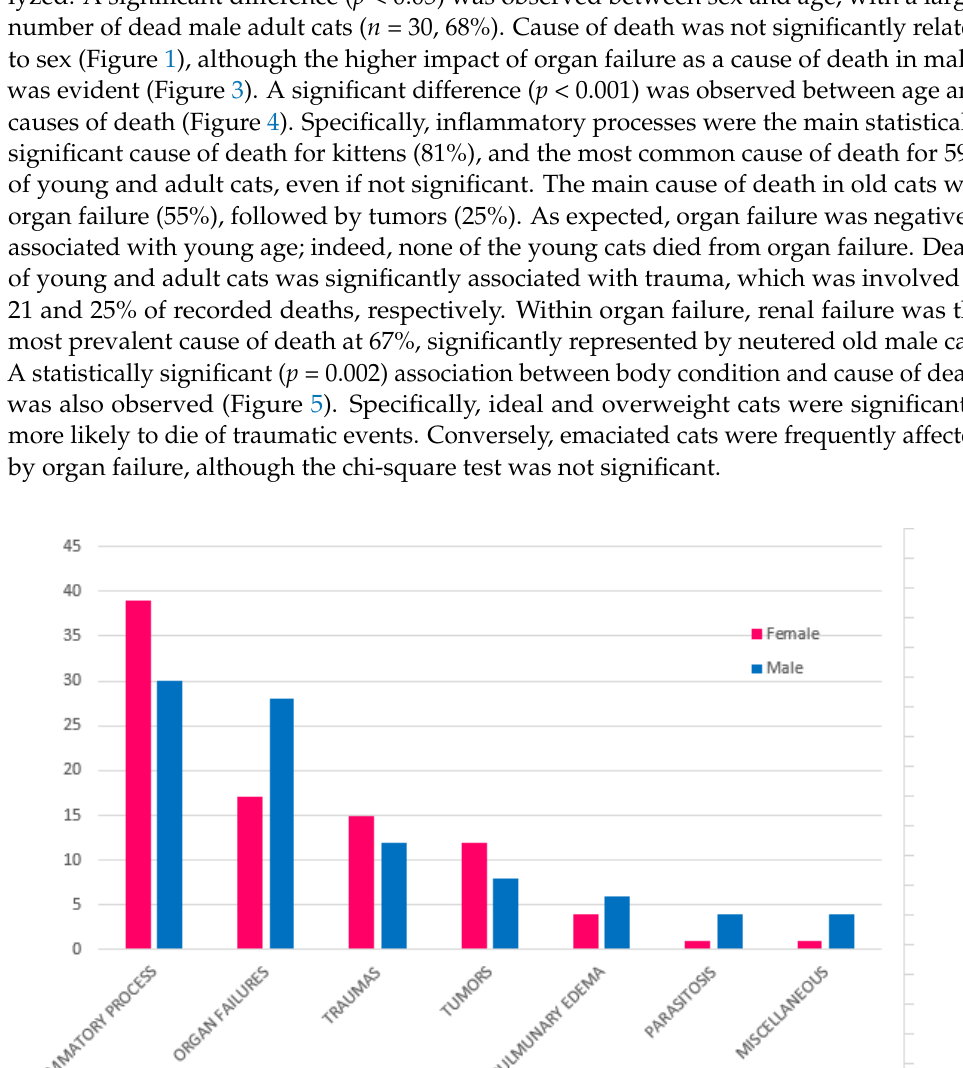
Figure 4. Relation between cause of death and age of colony cats included in the study . Figure 5. Relation between cause of death and body condition of colony cats included in the study .